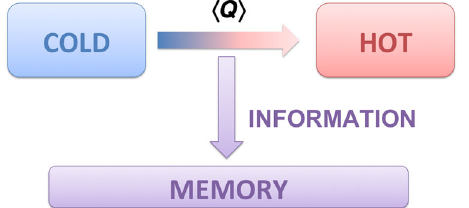
FIG. 3. Illustration of the generalized Clausius statement [Eq. (49)]. Heat can flow from the cold to the hot reservoir if information is written to